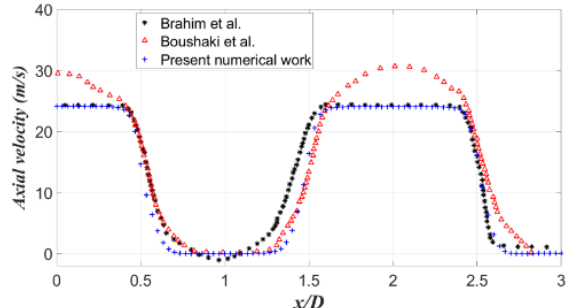
Figure 6. Radial velocity distribution for non-reactive oxy methane jets (Z/D = 3).